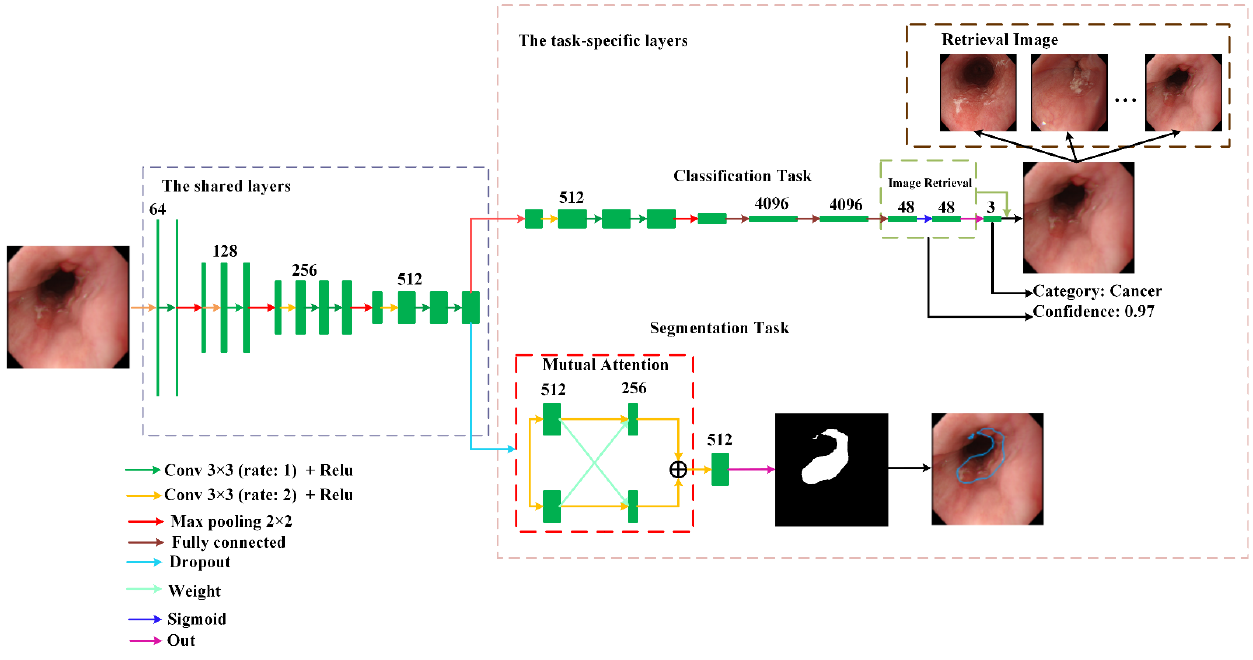
Figure 1. The network architecture of the proposed multi-task deep learning model.